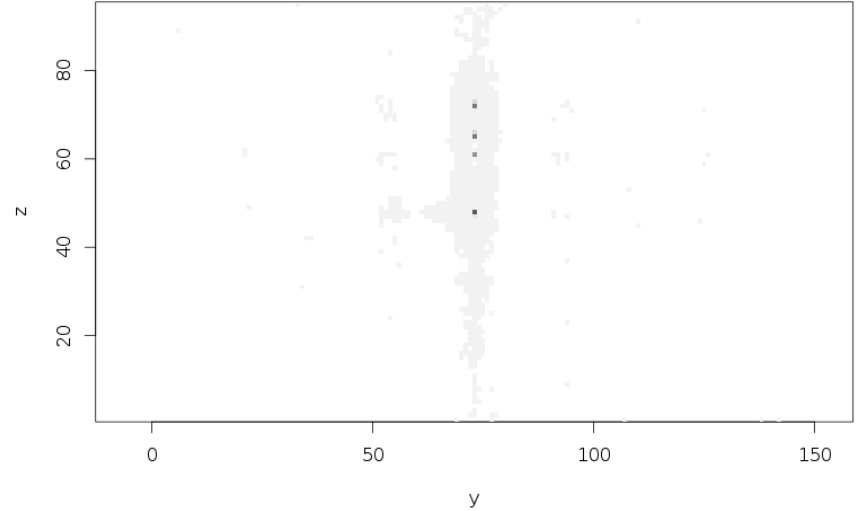
Figure 4. Reconstructed image of the Monte Carlo simulation of four point sources in Opalinus Clay